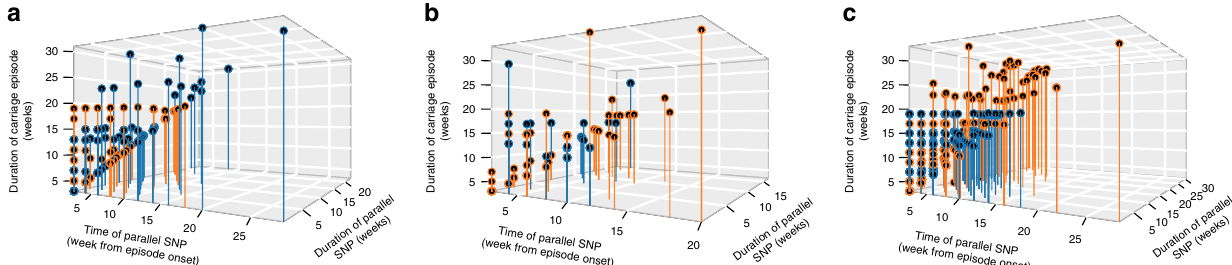
Fig. 7 Timing and duration of parallel mutation during natural colonisation. Type of parallel SNP is shown by different panels in the fi gure as follows; a non-synonymous, b synonymous, and c intergenic. The estimates were calculated for each extended colonisation episode with >3 sequenced isolates. The parallel SNPs coloured in orange were propagated throughout the episode after occurrence while those coloured in dark blue did not persist over the